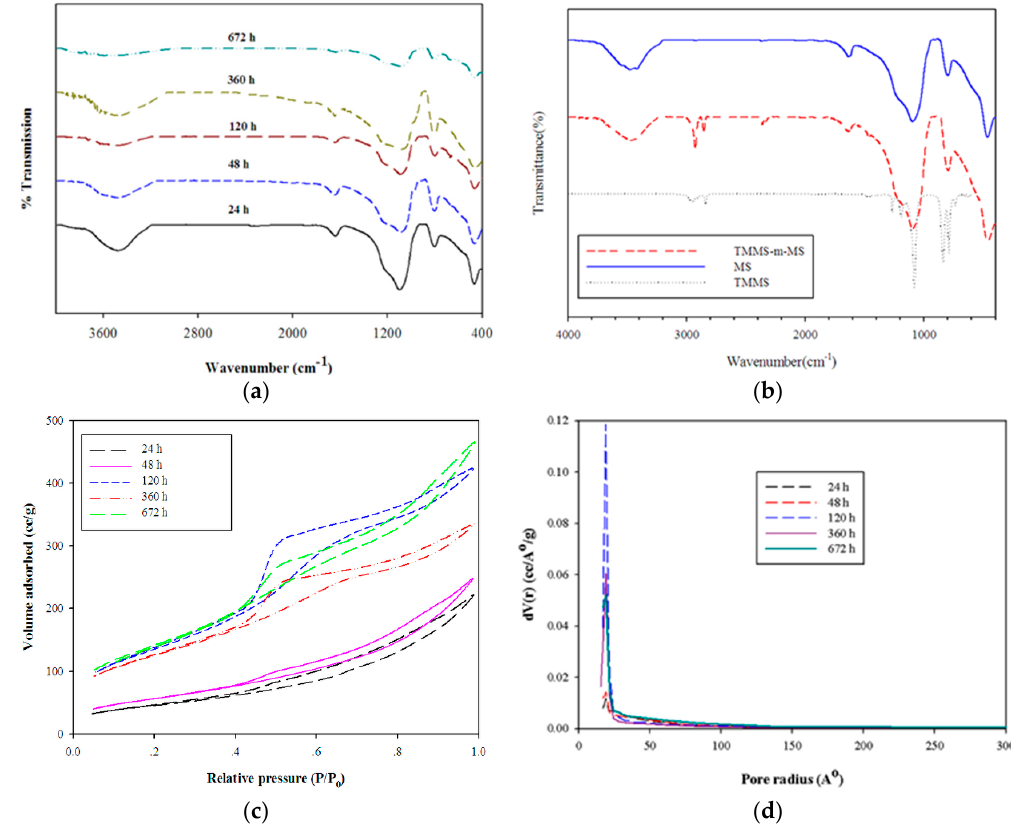
Figure 5. FTIR spectra of mesoporous silica prepared by various hydrolysis-ageing time periods ( a ), surface-modified silica (TMMS-m-MS) ( b , c ) N 2 sorption isotherms of mesoporous silica and ( d ) PSD curves for various hydrolysis-ageing periods.